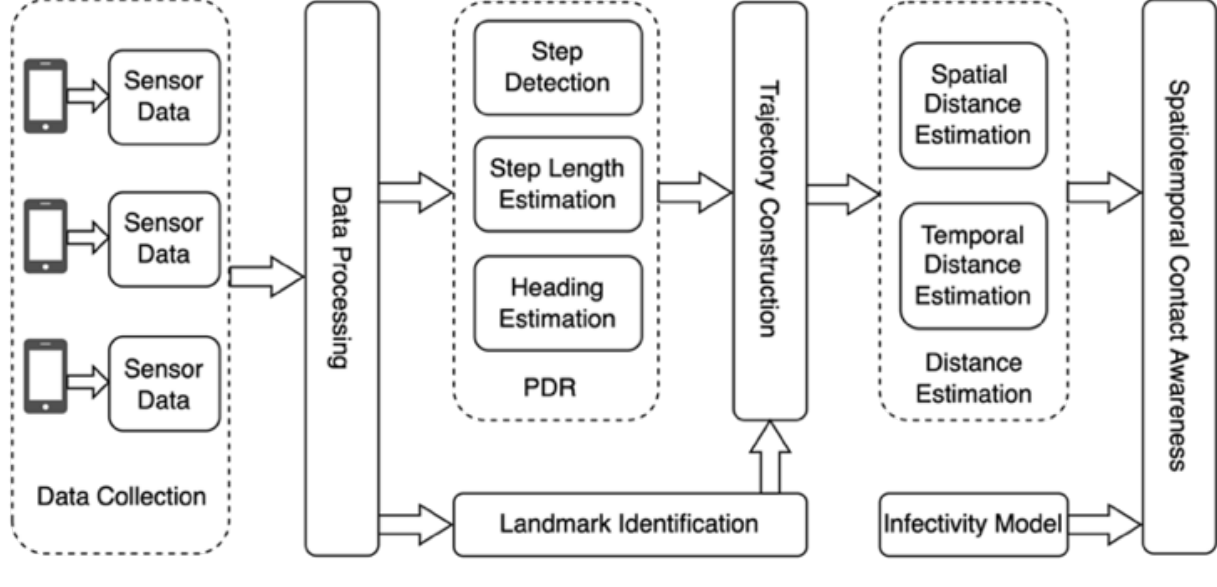
Figure 1. Overview of iSTCA.